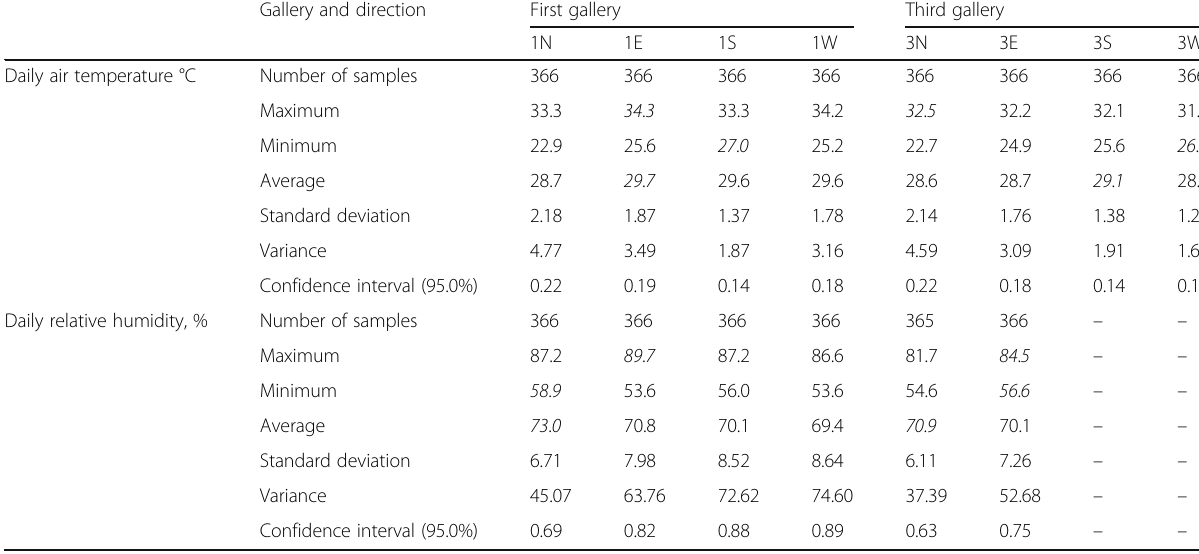
Fig. 7 Relationships between the water content of the hollow and gallery directions. Bars indicate ranges from maximum to minimum of water contents